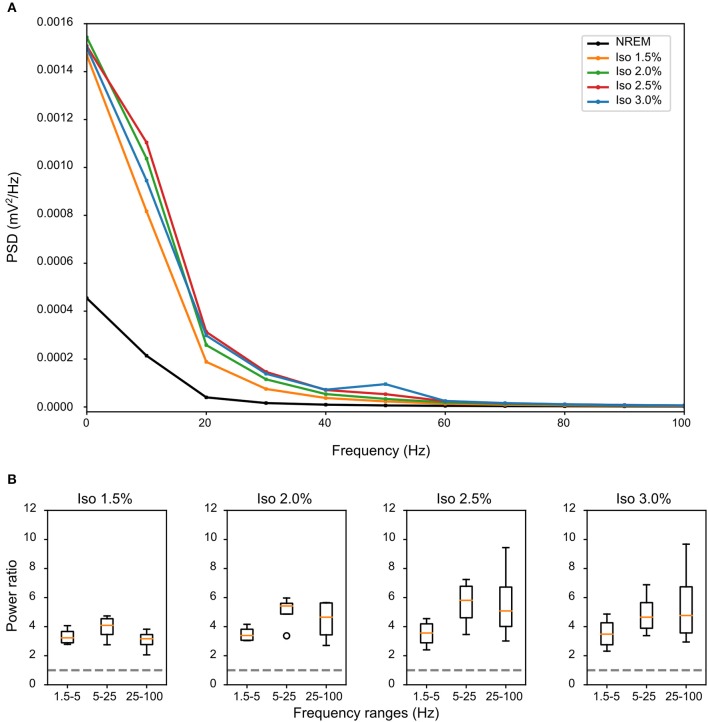
Differences in spectral composition of slow-waves under isoflurane anesthesia: (A) Mean power source density (PSD) over all birds and all episodes of non-rapid eye-movement (NREM) sleep (i.e., early and late NREM sleep combined) or all slow-wave episodes under different levels of isoflurane anesthesia. Each condition shows a power frequency distribution typical for pigeon sleep (Martinez-Gonzalez et al., 2008); however, PSD of slow-wave episodes under all levels of isoflurane is higher in all frequency bands when compared to NREM sleep. (B) Mean power ratio in the 1.5–5 Hz (slow-wave activity), 5–25 Hz and 25–100 Hz (gamma) bands was calculated over the mean of all slow-wave episodes from all birds (N = 4) during NREM sleep and different levels of isoflurane anesthesia. Power in all examined bands was higher during isoflurane anesthesia when compared to NREM sleep (i.e., stipulated line at y-axes = 1). The largest increase in power under increasing levels of isoflurane anesthesia occurred in the 25–100 Hz band.